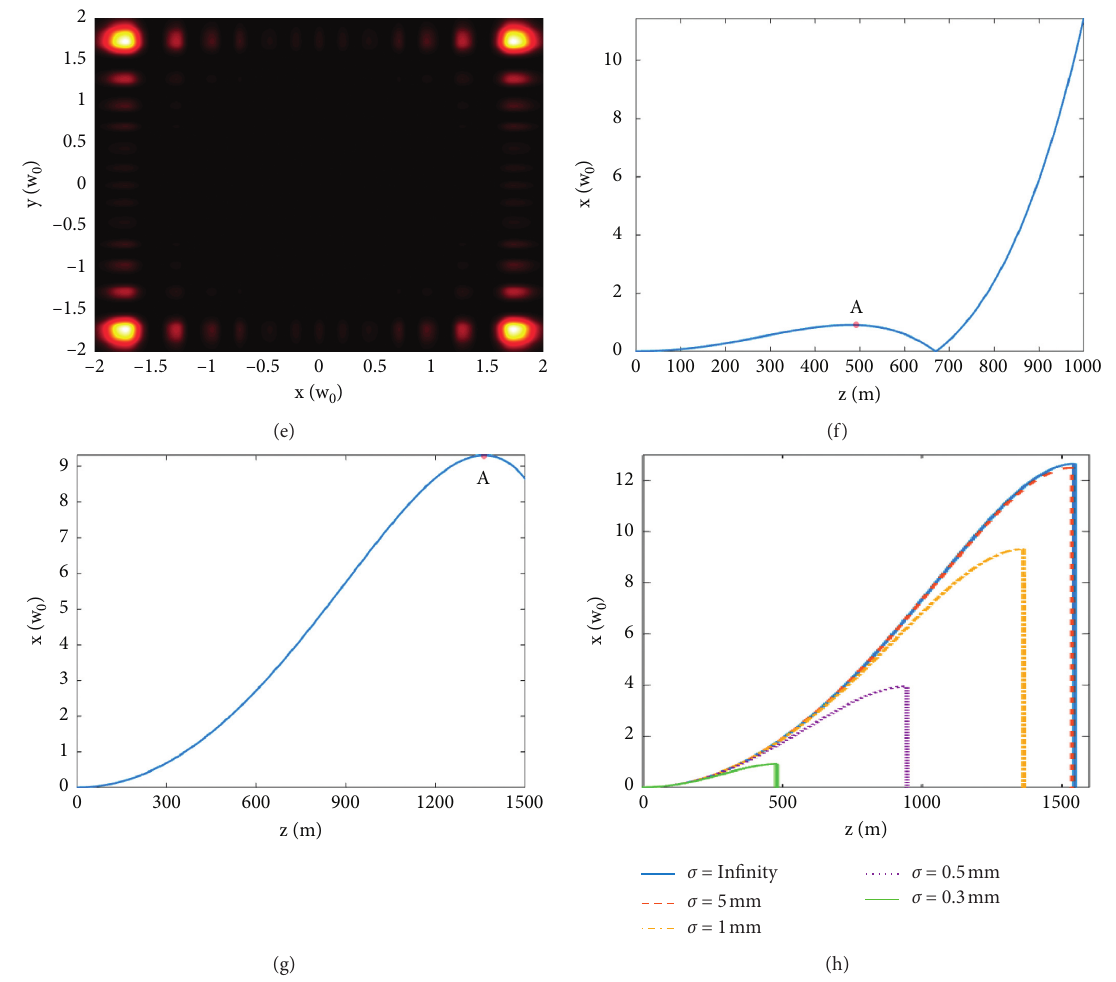
Figure 3: Influence of σ on PCAFABs’ evolution characteristics; A expresses the inflexion point, and other parameters are the same as those in Figure 1 except for a 0 � 0: (a) σ � 0.1mm, (z) � 100m; (b) σ � 0.3 mm, z � 100m; (c) σ � 1mm, z � 100m; (d) σ � 1 mm, z � 500m; (e) σ � 10mm, z � 500m; (f) parabolic trajectory for σ � 0.3mm; (g) parabolic trajectory for σ � 1mm; (h) beam transverse self-acceleration parabolic trajectory for different σ